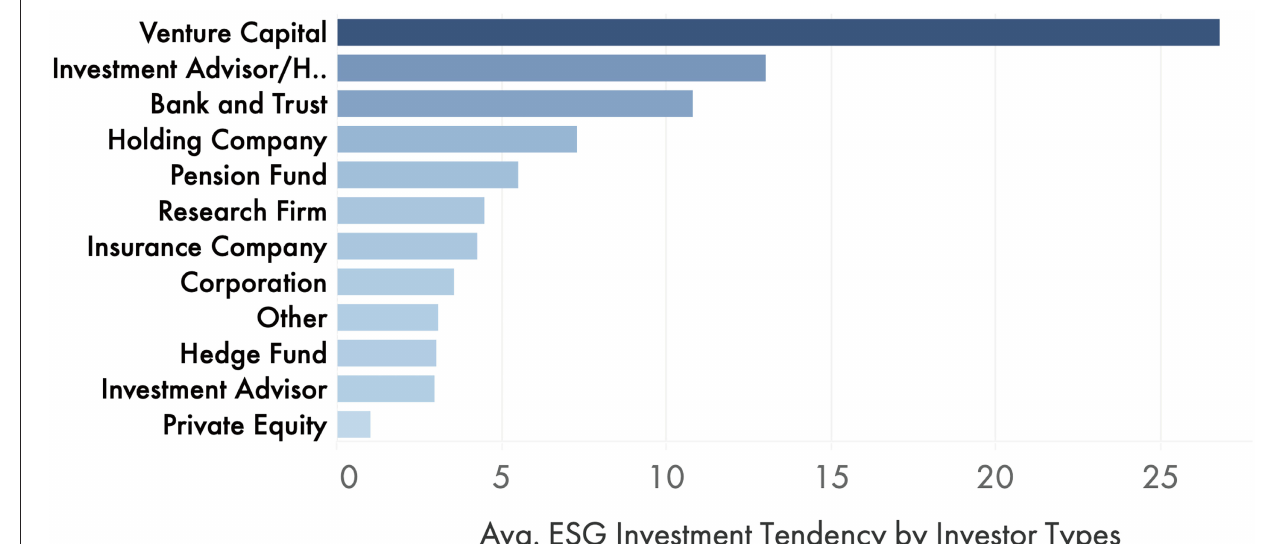
FIGURE 11 | Average ESG tendency by the investor